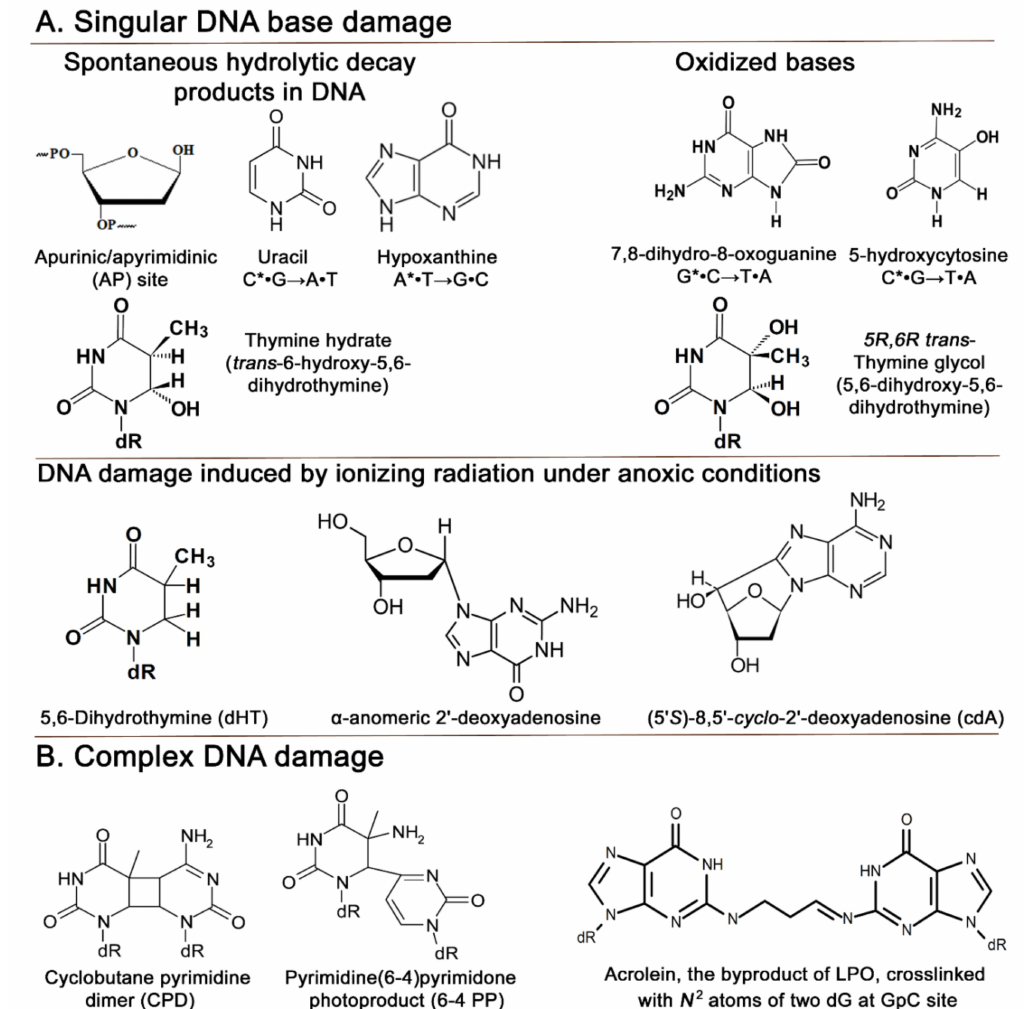
Figure 2. Chemical structures of spontaneous and induced DNA lesions. ( A ) Singular DNA base damage, including products of spontaneous DNA decay, oxidative DNA base damage and DNA base modifications generated by exposure to ionizing radiation under anoxic conditions. ( B ) Complex DNA damage, including bulky DNA adducts induced by UV light and inter-strand DNA crosslinks generated by reactive